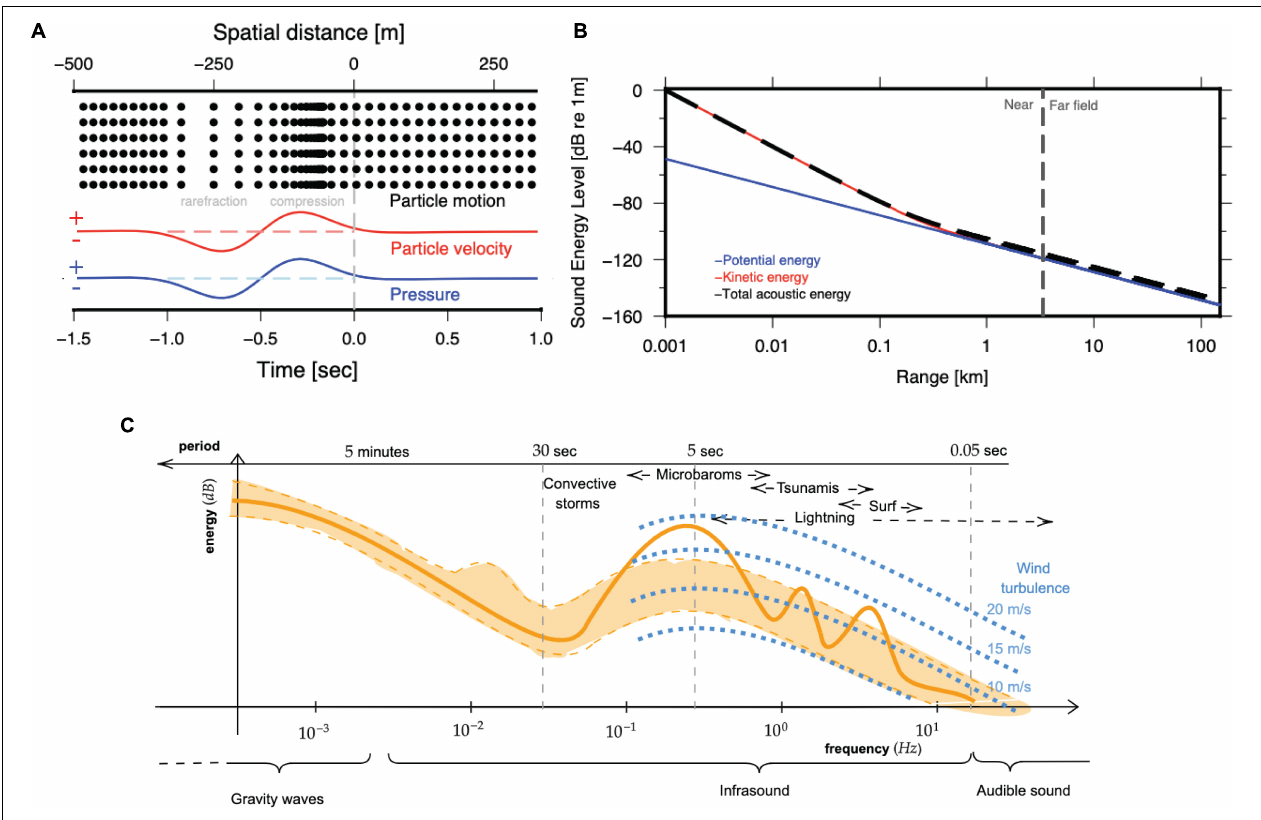
FIGURE 1 | Infrasonic wave-field parameters. (A) Depiction of an acoustic wave (black dots) as alternating compressions and rarefactions, leading to perturbations in particle velocity (red) and pressure (blue). (B) The decrease and partitioning of acoustic energy with range and transition from near- to far-field for a spherical sound wave at 0.2 Hz. The total acoustic energy (dashed black) is composed of potential (blue) and kinetic (red) energy, related to pressure and particle motion, respectively. While kinetic energy dominates in the near-field, both forms are in equilibrium in the far-field. (C) Schematic representation of pressure spectra due to coherent infrasound (shaded orange) and wind noise (blue); the orange shaded area between the dashed lines represent average background quantities, while the solid line represents a random snapshot with three spectral speaks. Acoustic signal detection is possible if wind noise levels are below the acoustic signal power, i.e., when the dashed blue line is below the solid orange line, which depends on the source power as well as the wind